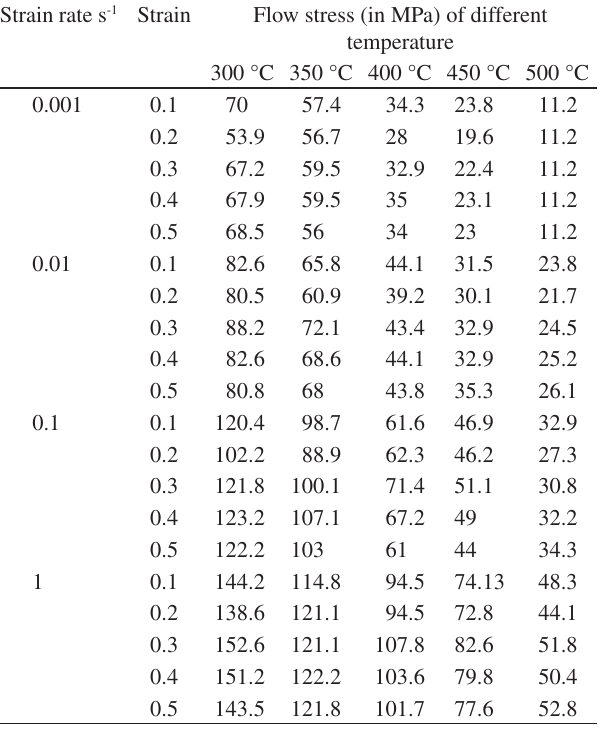
Table 1. Flow stress values for Mg + 4.5%Ti composite at various strains, strain rate and temperatures. Strain rate s -1 Strain Flow stress (in MPa) of